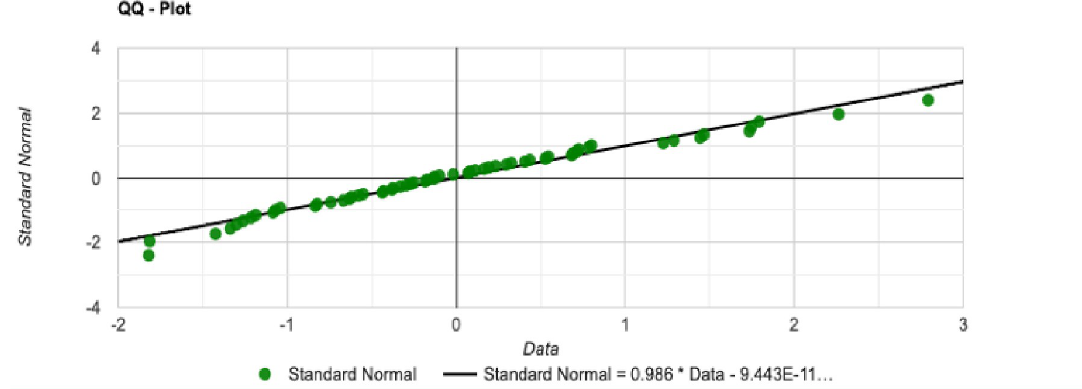
Fig 32. QQ-Plot for the initial tour cost in the QA